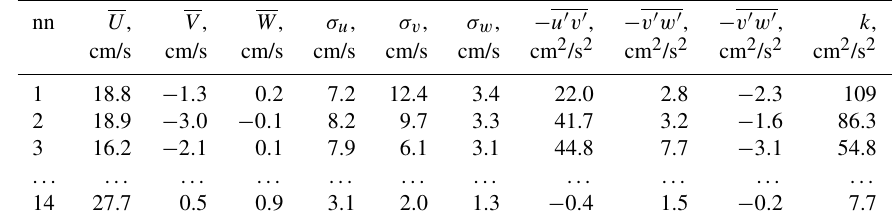
Table 2. The structure of post-processed data for velocity measurements in longitudinal and lateral transects. nn U , V , W , σ u , σ v , σ w , − u (cid:48) v (cid:48) , − v (cid:48) w (cid:48) , − v (cid:48) w (cid:48) , k , cm/s cm/s cm/s cm/s cm/s cm/s cm 2 /s 2 cm 2 /s 2 cm 2 /s 2 cm 2 /s 2 1 18.8 − 1 . 3 2